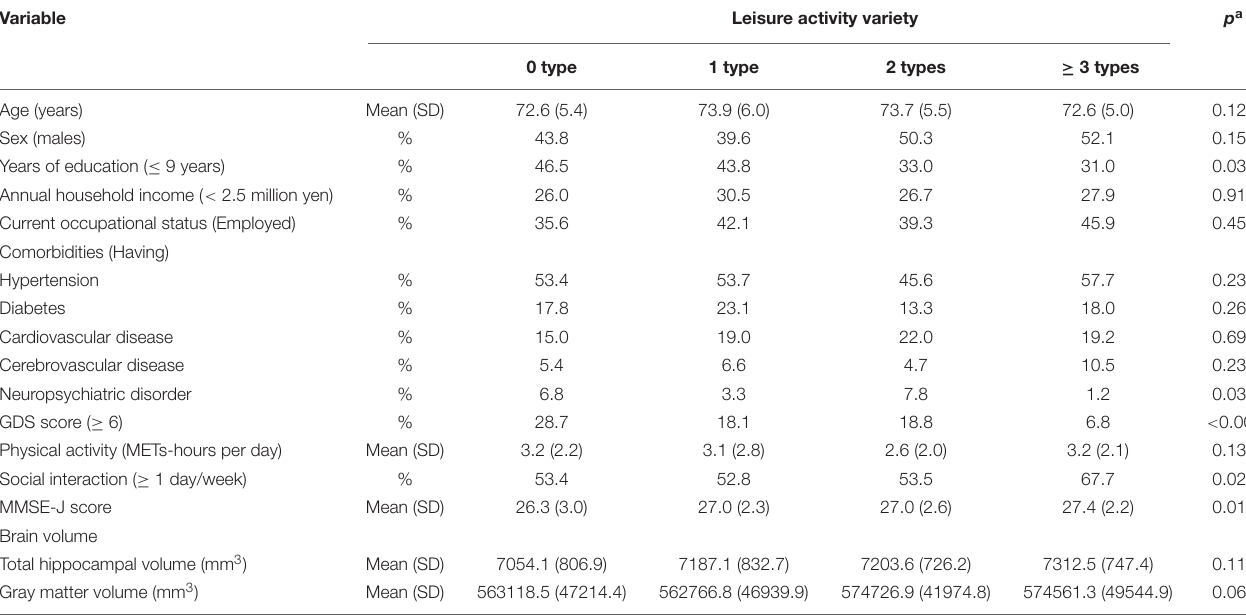
TABLE 2 | The comparison of the participant’s characteristics by categories of leisure activity ( N = 482).